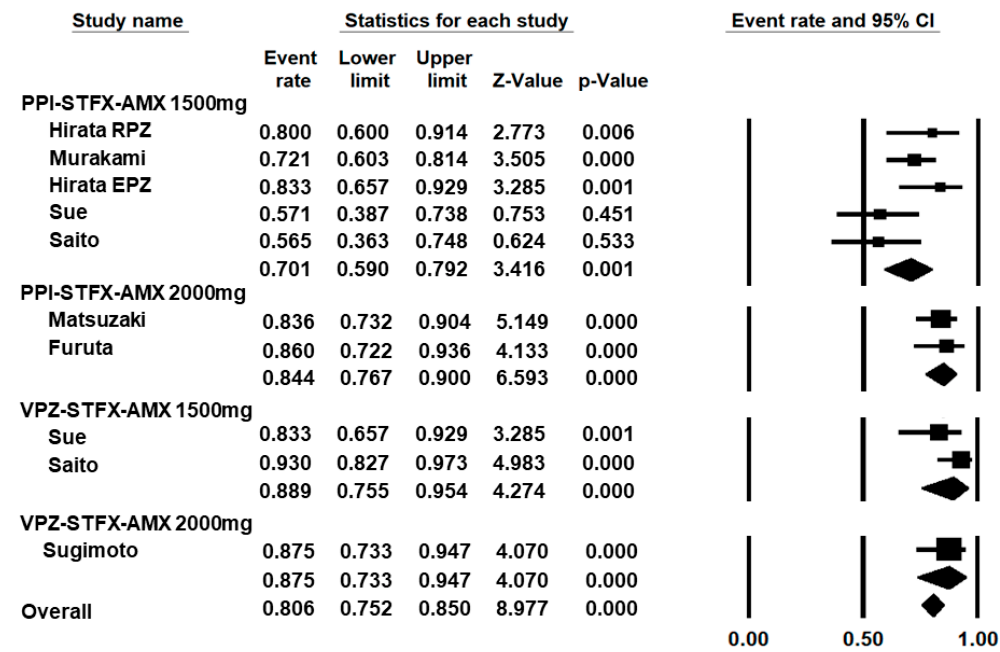
Figure 2. Eradication rates of 7 days regimen with PPI (proton pump inhibitor) or vonoprazan. (VPZ)–sitafloxacin (STFX)–